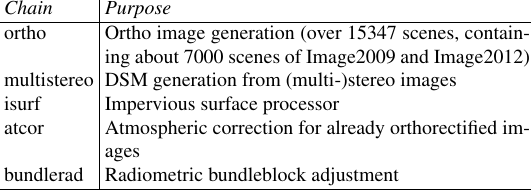
Table 2: General purpose processing chains in CATENA